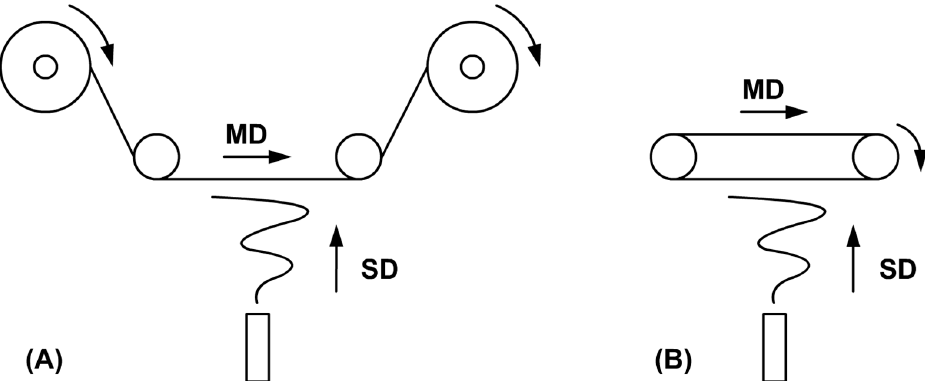
Figure 1. Diagrams of two fundamentally different basic collector designs with moving substrates used in industrial devices for electrostatic spinning—roll-to-roll ( A ) and endless belt ( B ), where SD is spinning direction and MD is machine direction. spinning direction and MD is machine